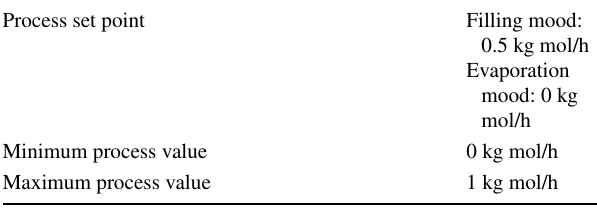
Fig. 5 Effect of adding ethane on LPG heating value